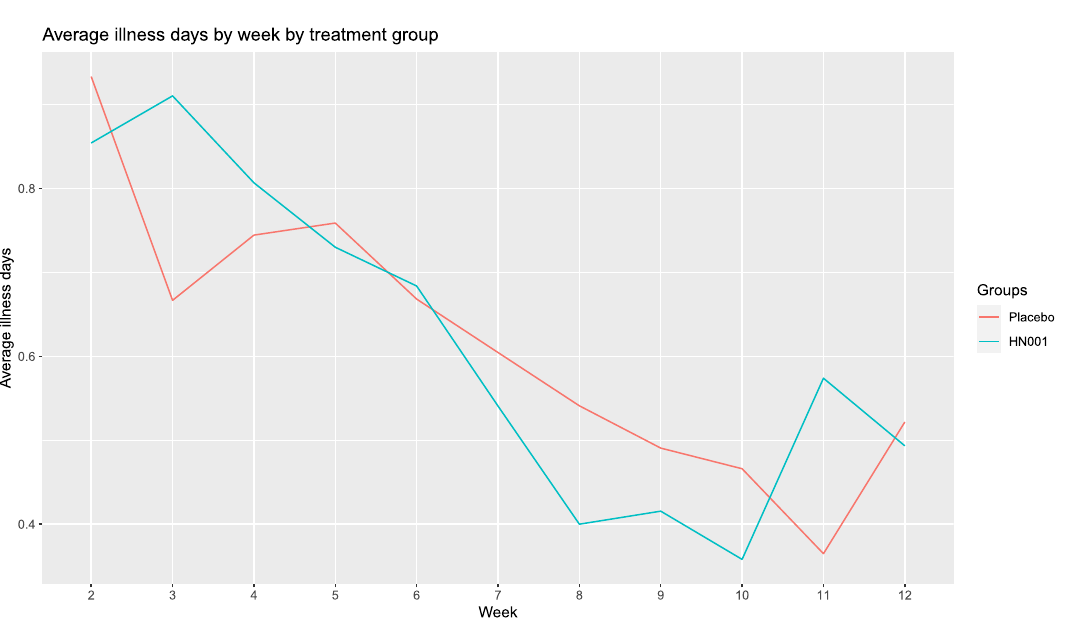
Figure 2. Average illness days per week for weeks 2–12 of the trial for the probiotic and placebo groups.